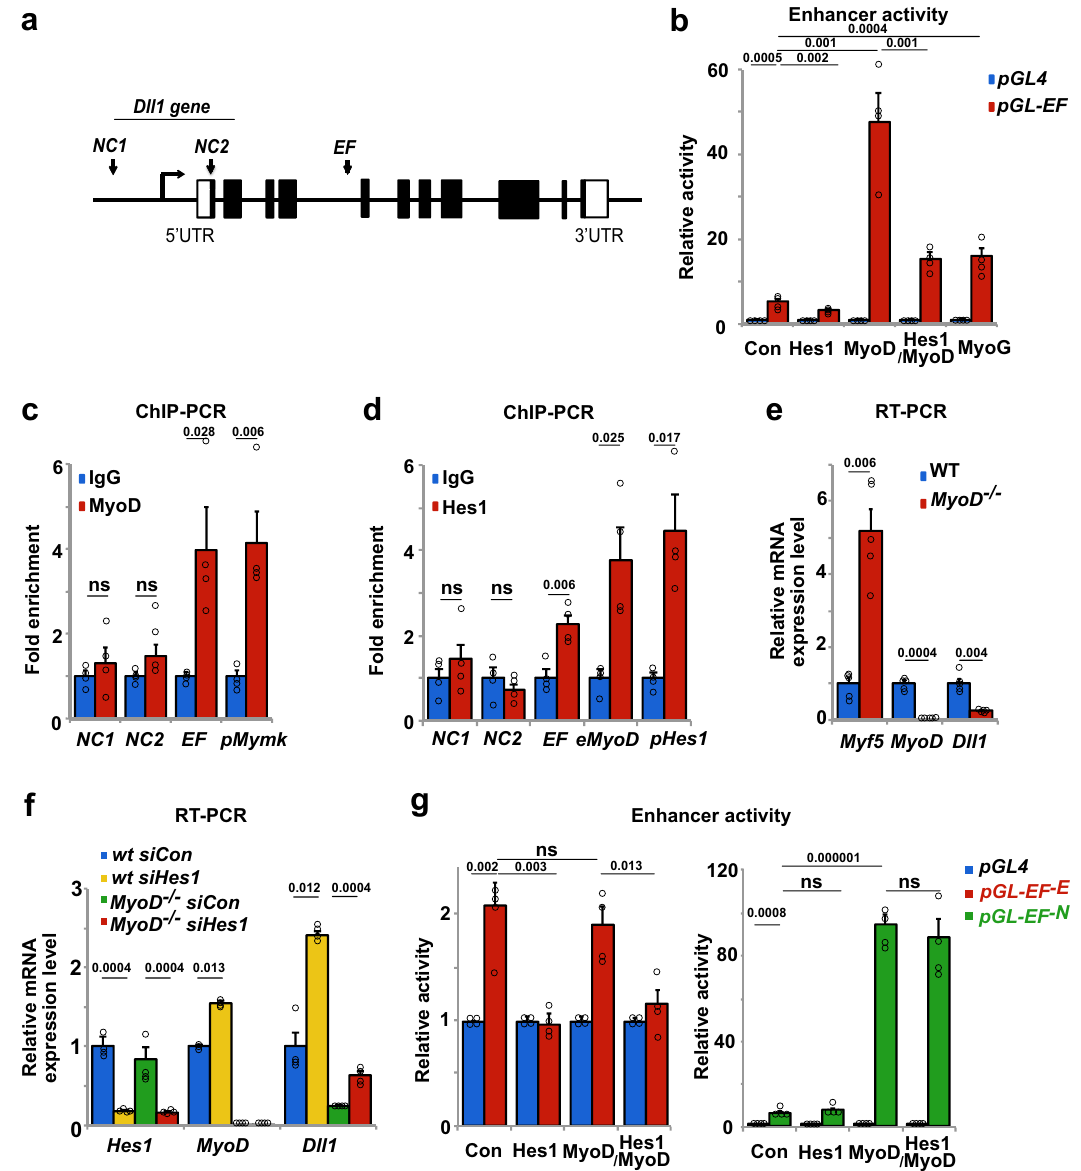
MyoDCon Hes1 MyoD Hes1 Con Hes1 MyoD Hes1 / MyoD / Fig. 3 Expression of Dll1 is regulated by MyoD and Hes1. a Schematic display of the Dll1 gene; the enhancer fragment ( EF ) corresponds to sequences located in the fourth intron. Two additional fragments were used as negative controls ( NC1 , NC2 ). b Test of the enhancer activity of the EF fragment using the dual-luciferase reporter system ( pGL4 luciferase plasmid without an enhancer, blue bars; pGL-EF luciferase plasmid containing EF enhancer, red bars); cells co-transfected with pCAG-nGFP (control, con), Hes1 , MyoD , Hes1/MyoD and MyoG expression plasmids were analyzed; n = 4 experiments. c ChIP-PCR experiment analyzing MyoD binding to EF and NC1/NC2 . The known binding site in the Myomaker ( pMymk ) gene was used as a positive control; n = 4 experiments. d ChIP-PCR experiment analyzing Hes1 binding to EF , and to NC1/NC2 . Known binding sites for Hes1 in the MyoD locus ( eMyoD 23 kb upstream the MyoD transcript initiation site) and the Hes1 promoter ( pHes1 ) were used as positive controls; n = 4 experiments. e qPCR analysis of Dll1 , MyoD and Myf5 transcripts in wild-type (wt) and MyoD -/- mutant muscle stem cells, demonstrating MyoD-dependent Dll1 expression; n = 5 animals. f qPCR analysis of Hes1 , MyoD and Dll1 in muscle stem cells isolated from wild-type and MyoD − / − mice; cells were further treated with control or Hes1 siRNAs; n = 4 experiments. g Comparison of the enhancer activity using the dual-luciferase reporter system; pGL4 luciferase plasmid without an enhancer (blue bars); pGL4-EF -E luciferase plasmid containing enhancer lacking E-box sequences (red bars); pGL4-EF -N luciferase plasmid containing enhancer lacking N-box sequences. Control (con) cells co-transfected with pCAG-nGFP , and cells co-transfected with Hes1 , MyoD, and Hes1/MyoD expression plasmids were analyzed; n = 4 experiments. Data are presented as mean values ± SEM. Exact p values are indicated, unpaired two-sided t -test.